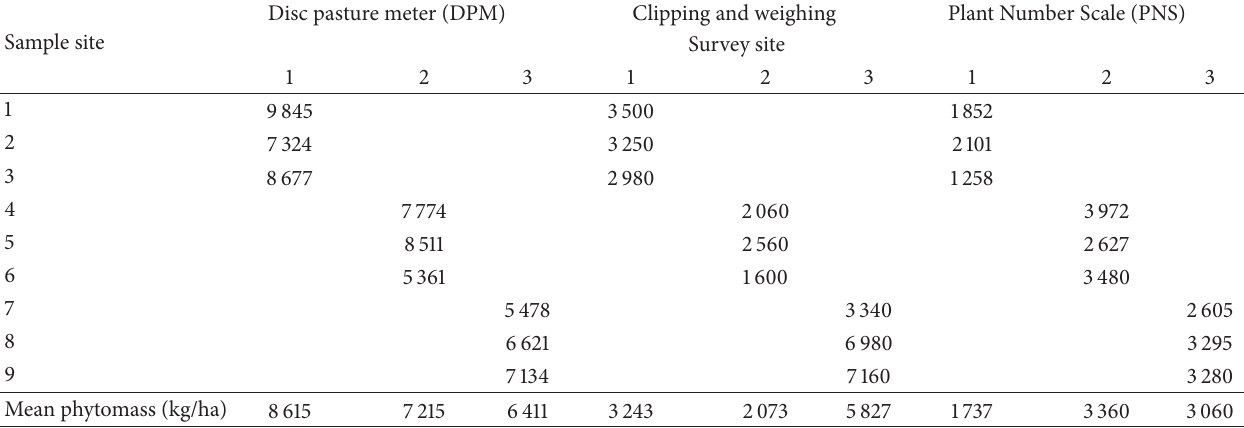
Table 1: Mean phytomass values (kg/ha) calculated for each sample site at three survey sites using the different techniques. Sample site